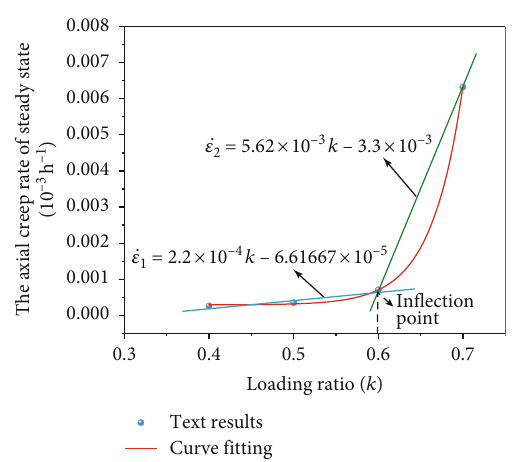
Figure 10: Isochronal stress-strain curves.